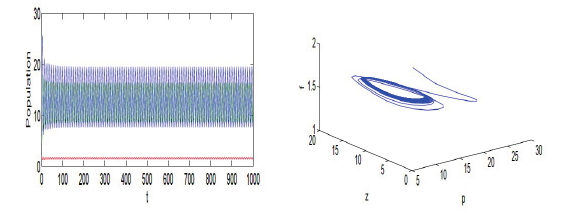
Fig. 4: Another bifurcating stable periodic orbit around R * at τ = 20